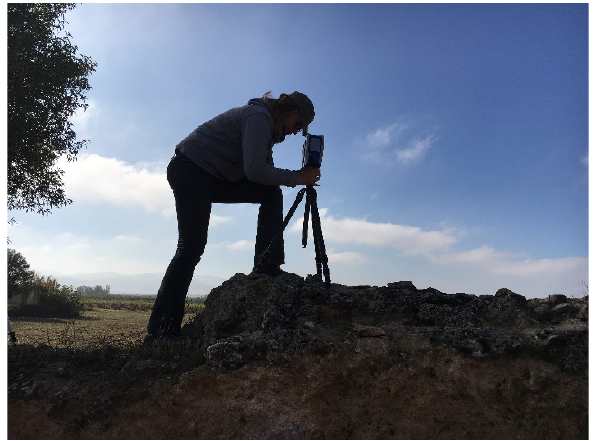
Figure 3. TLS data collection on top of section of Roman